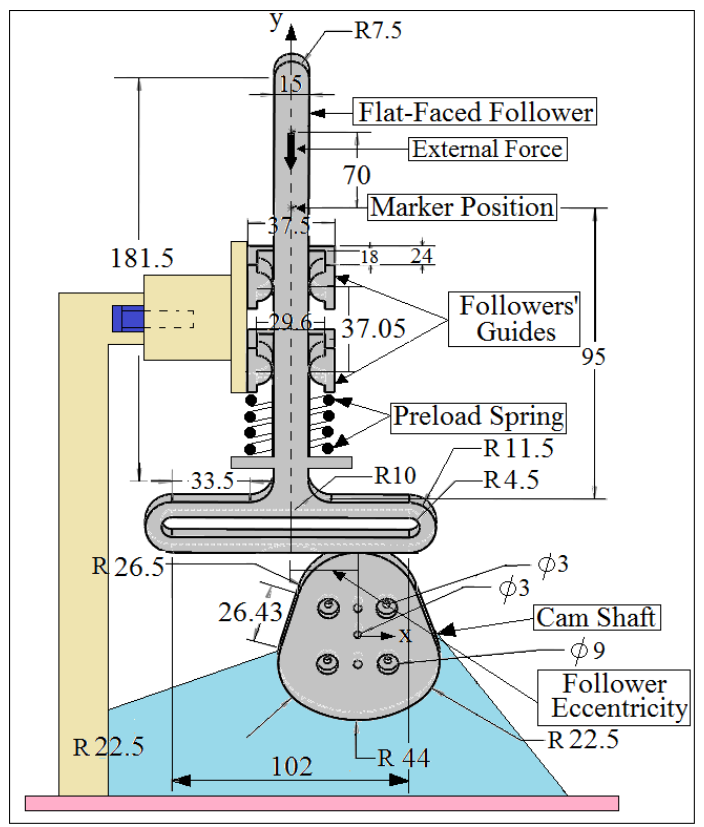
Figure 1. Polydyne cam with an offset flat-faced follower.